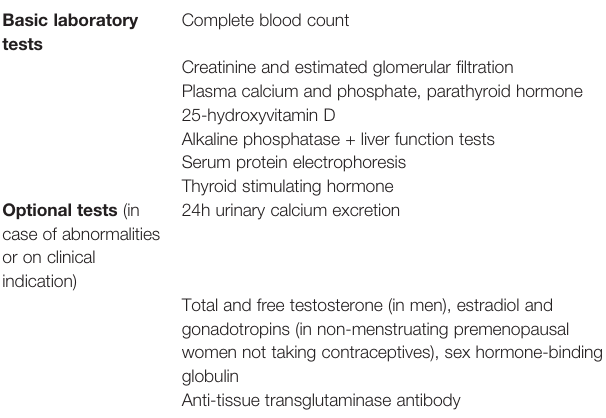
TABLE 3 | Recommended laboratory tests in the evaluation of glucocorticoid- induced osteoporosis. Basic laboratory